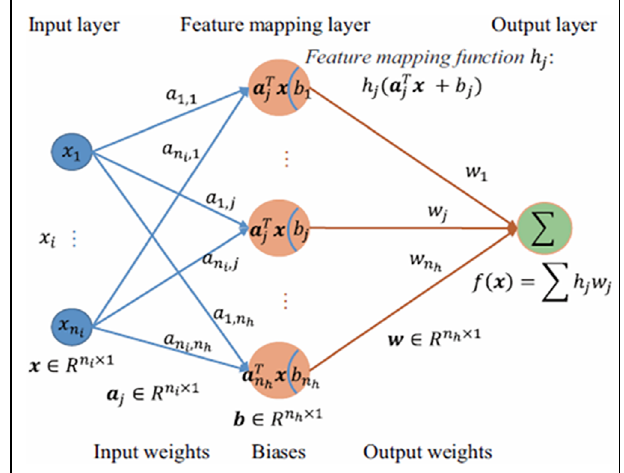
FIGURE 2 | General structure of the